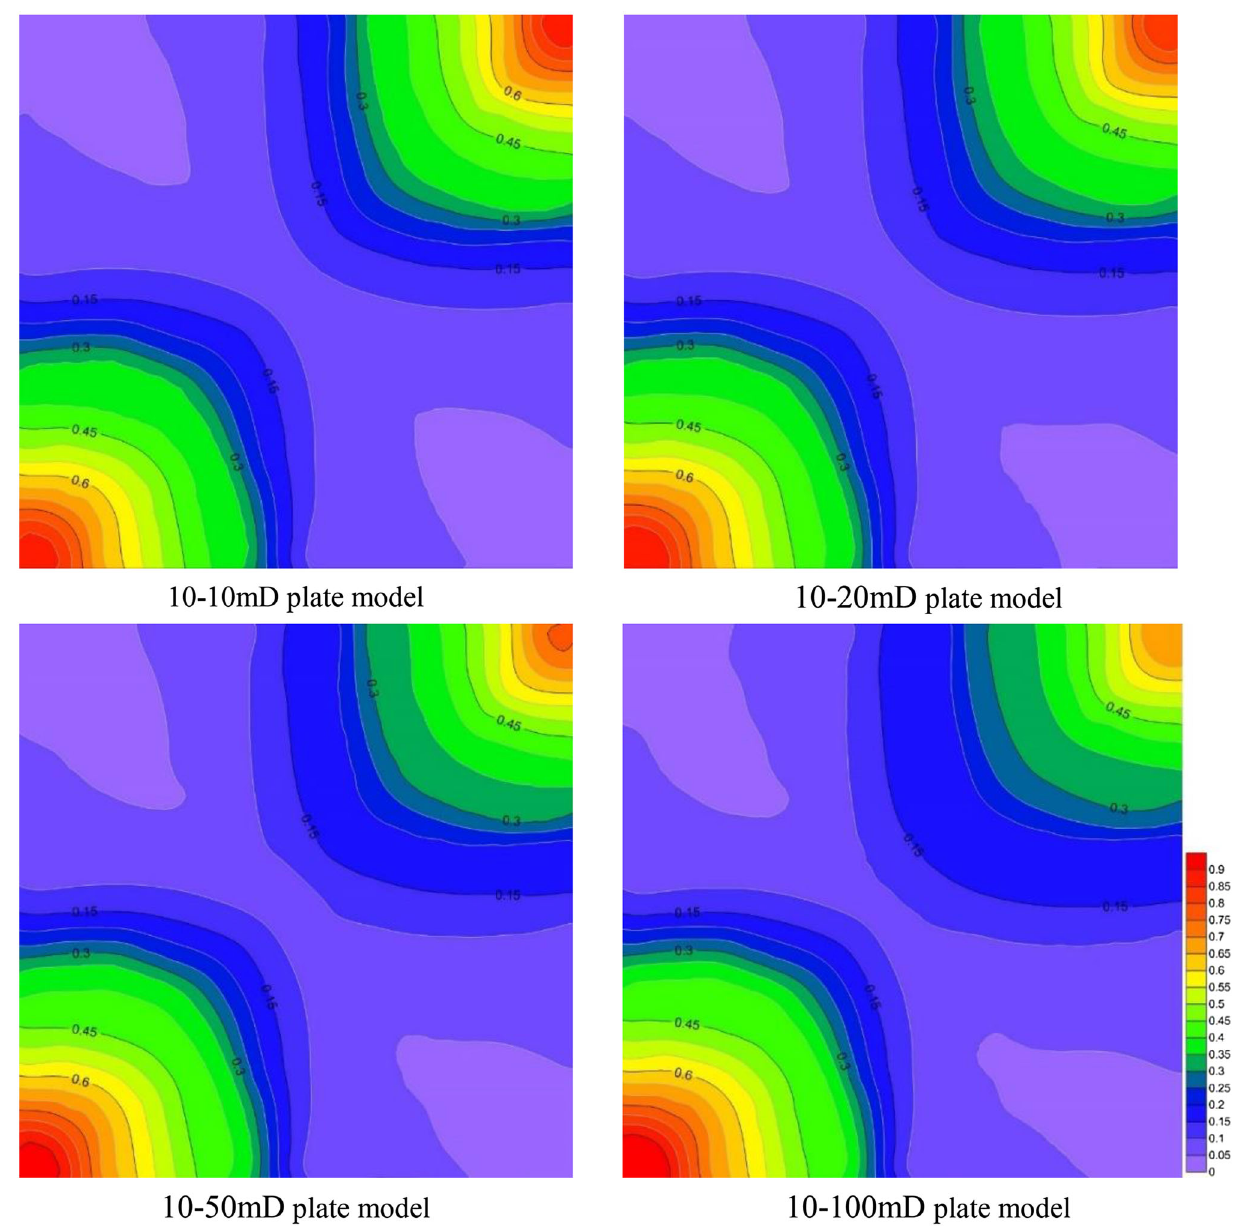
Fig. 5 Pressure gradient distribution maps of artificial core plate